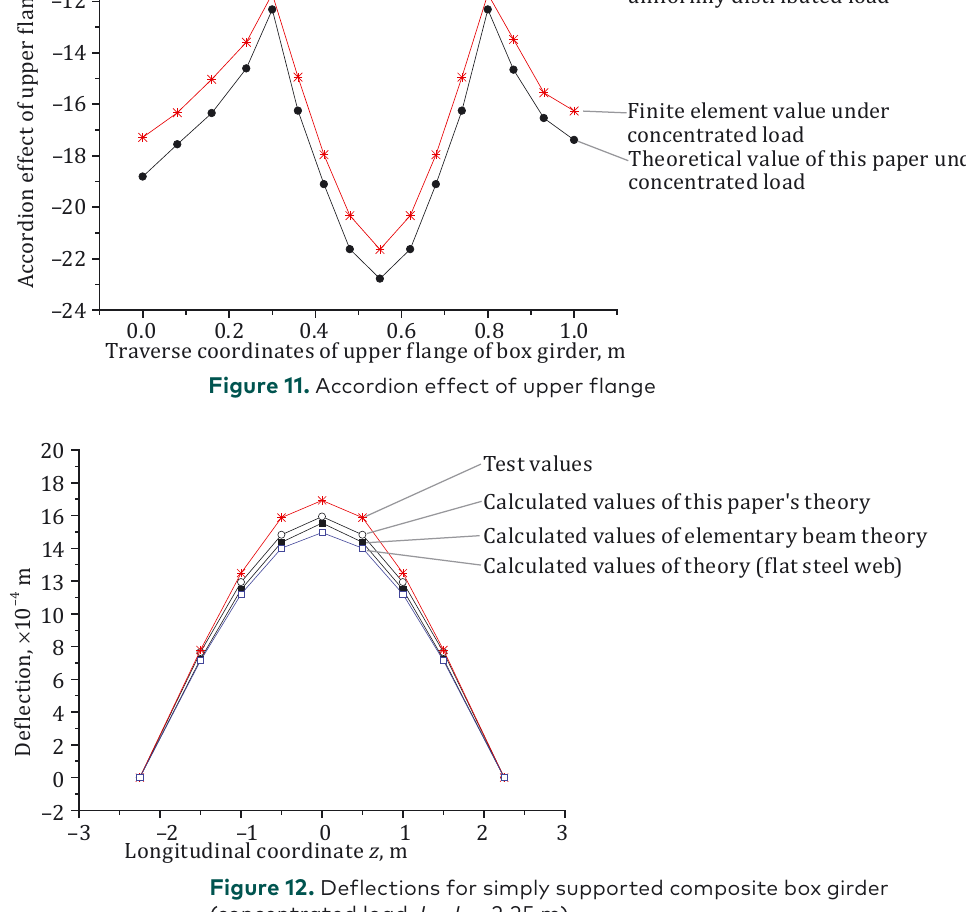
Figure 12. Deflections for simply supported composite box girder Longitudinal coordinate (concentrated load, L 1 = L 2 = 2.25 m)